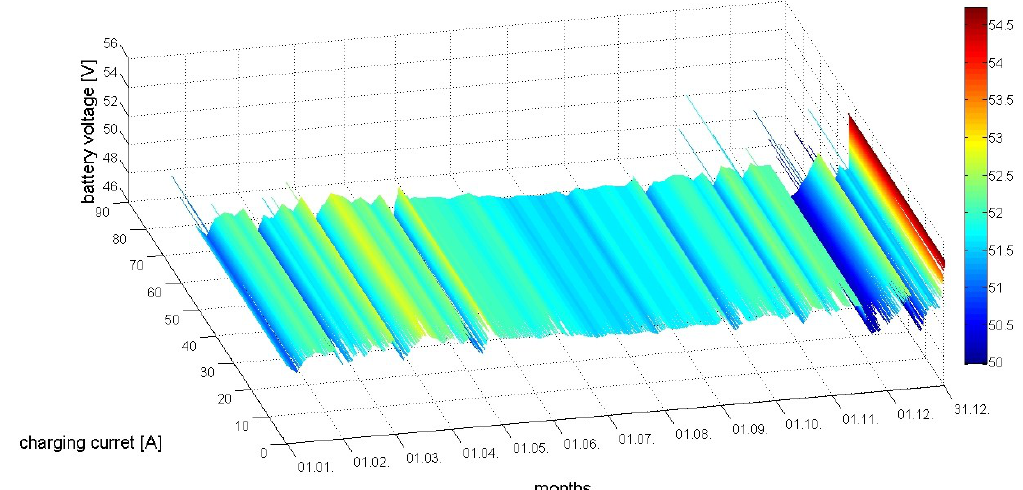
Figure 15. Interdependence of total charging current and battery voltage for the BSS C on a yearly